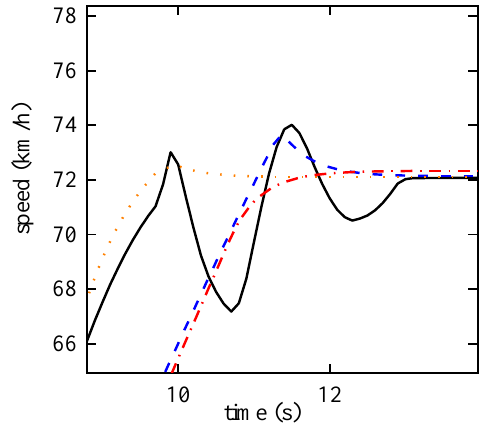
Figure 22. Enlarged view of vehicle speed.